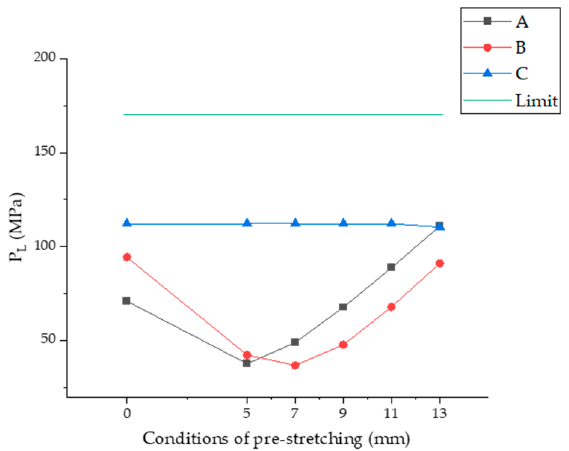
Figure 10. P L assessment at positions A, B and C under load case 1 with varying pretensions.